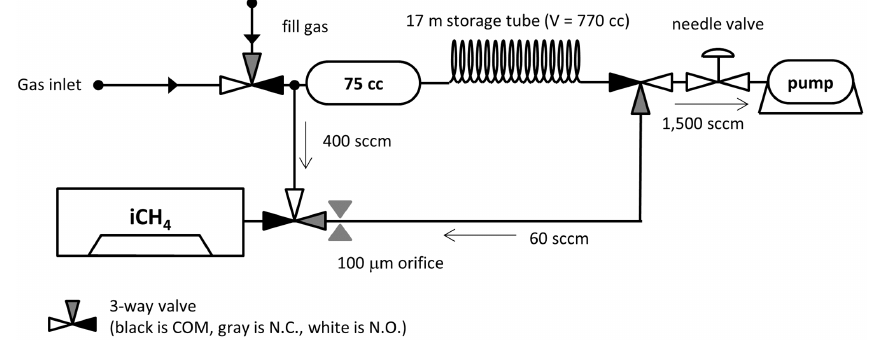
Figure 11. Apparatus for measuring the isotope ratio and ethane-to-methane ratio of single plumes in the mobile lab. For survey mode, all three-way valves are in “normally open” (N.O.) position (white), and the instrument measures the real-time signal at the input to the 770cc storage tube. The flow through the tube is set by the pump and needle valve. When a plume is detected at the instrument, the three-way valves are switched to “normally closed” (N.C.) position (gray) and the instrument slowly re-analyzes the gas stored in the long tube.